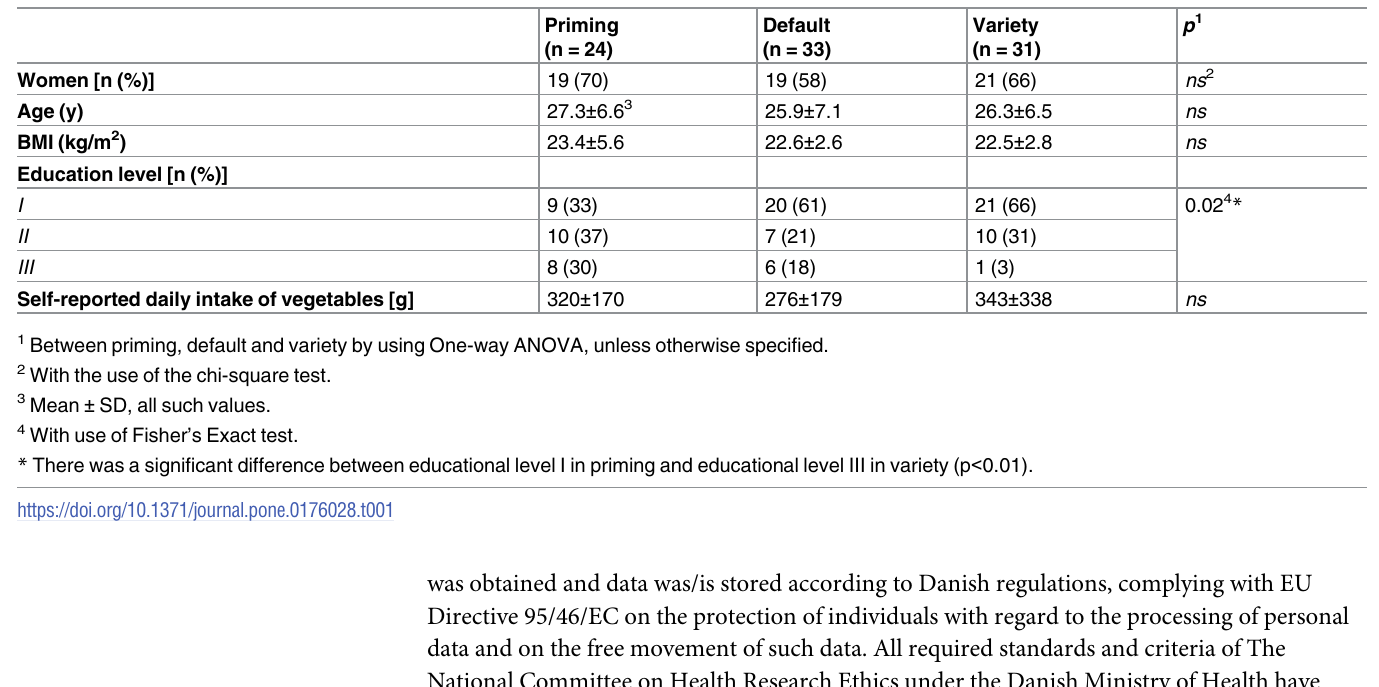
Table 1. Characteristics of participants—Divided by choice architecture approaches: Priming, default and variety.